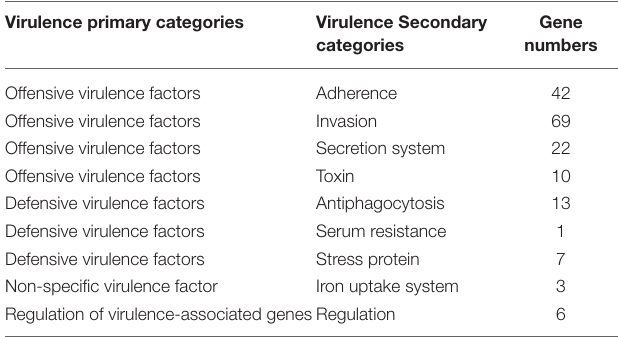
TABLE 2 | The annotation of virulence factors of the strain GXFL1-4 in VFDB